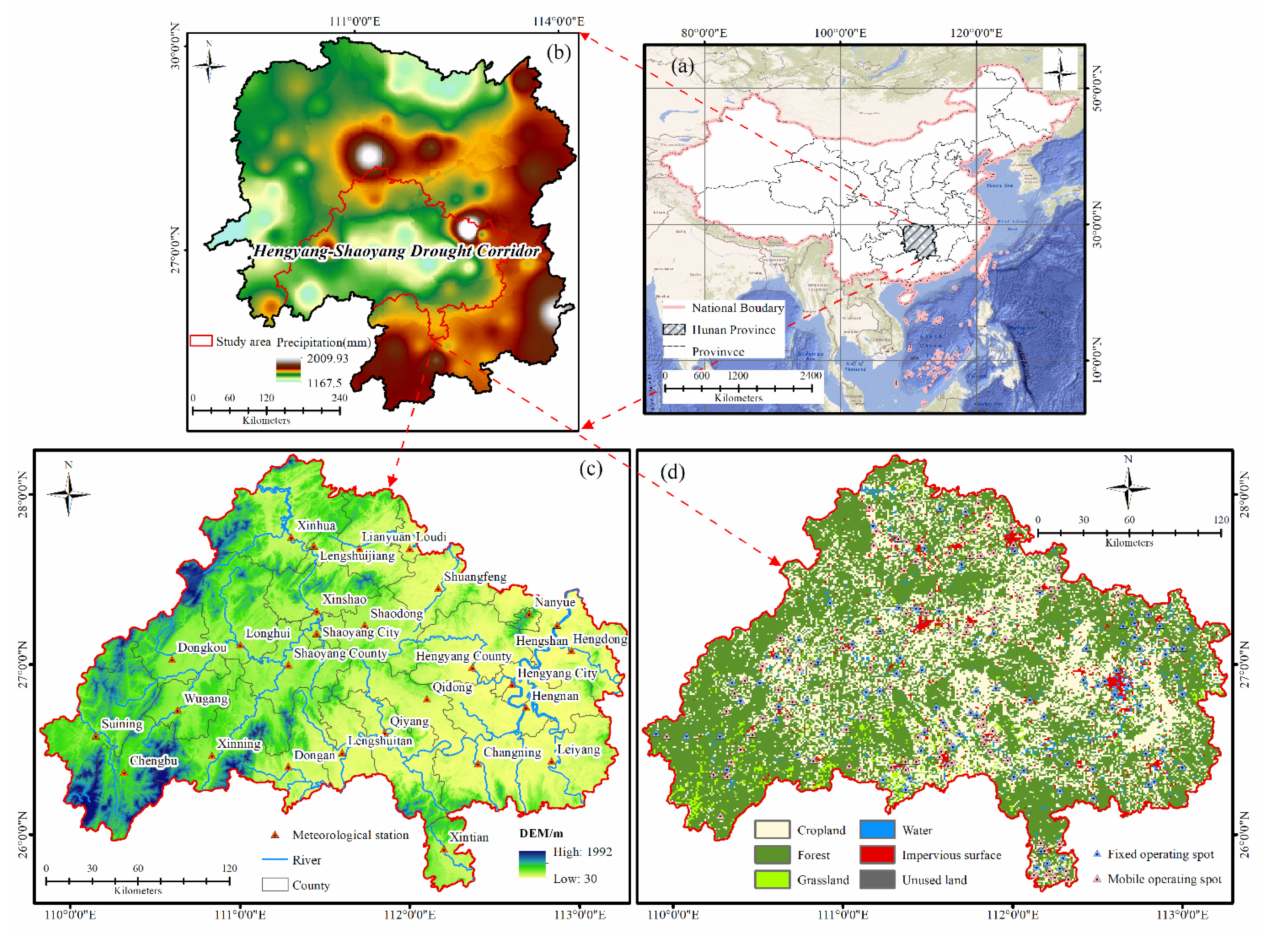
Figure 1. ( a ) Geographical distribution of Hunan Province (HP) in China; ( b ) location of the Hengyang-Shaoyang Drought Corridor (HSDC) in HP, and spatial pattern of average annual precip- itation in the province from 1960 to 2019; ( c ) digital elevation model, county-level divisions, main rivers, and meteorological stations of the HSDC; and ( d ) land use/land cover and locations of artificial precipitation operating spots in